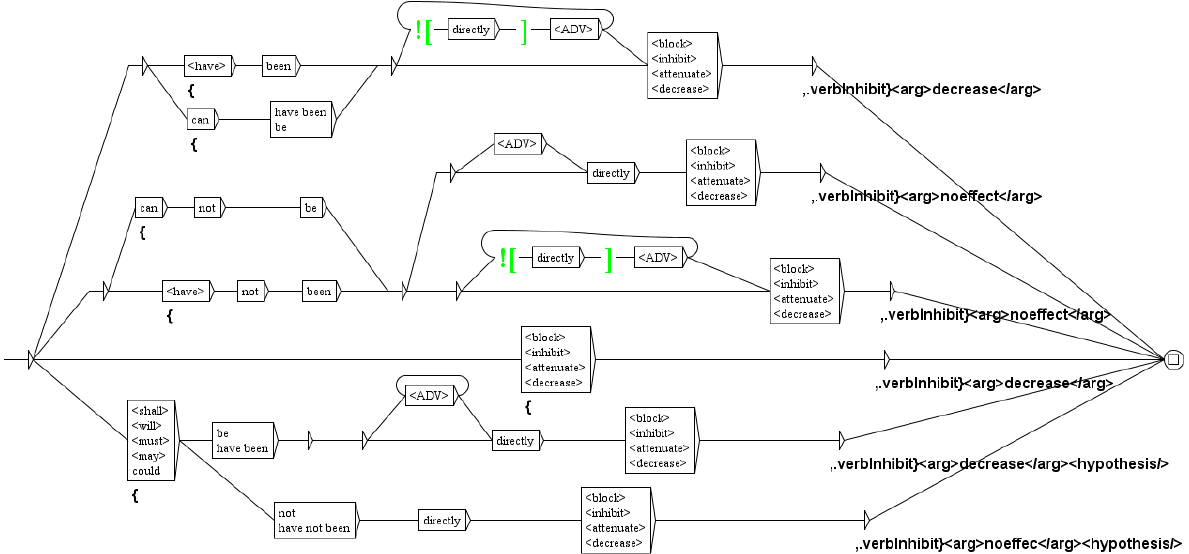
Figure 10. The graph to tag inhibition